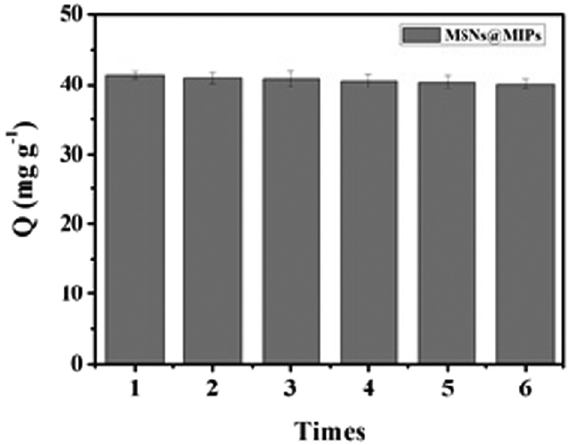
Figure 11: Regeneration experiments for